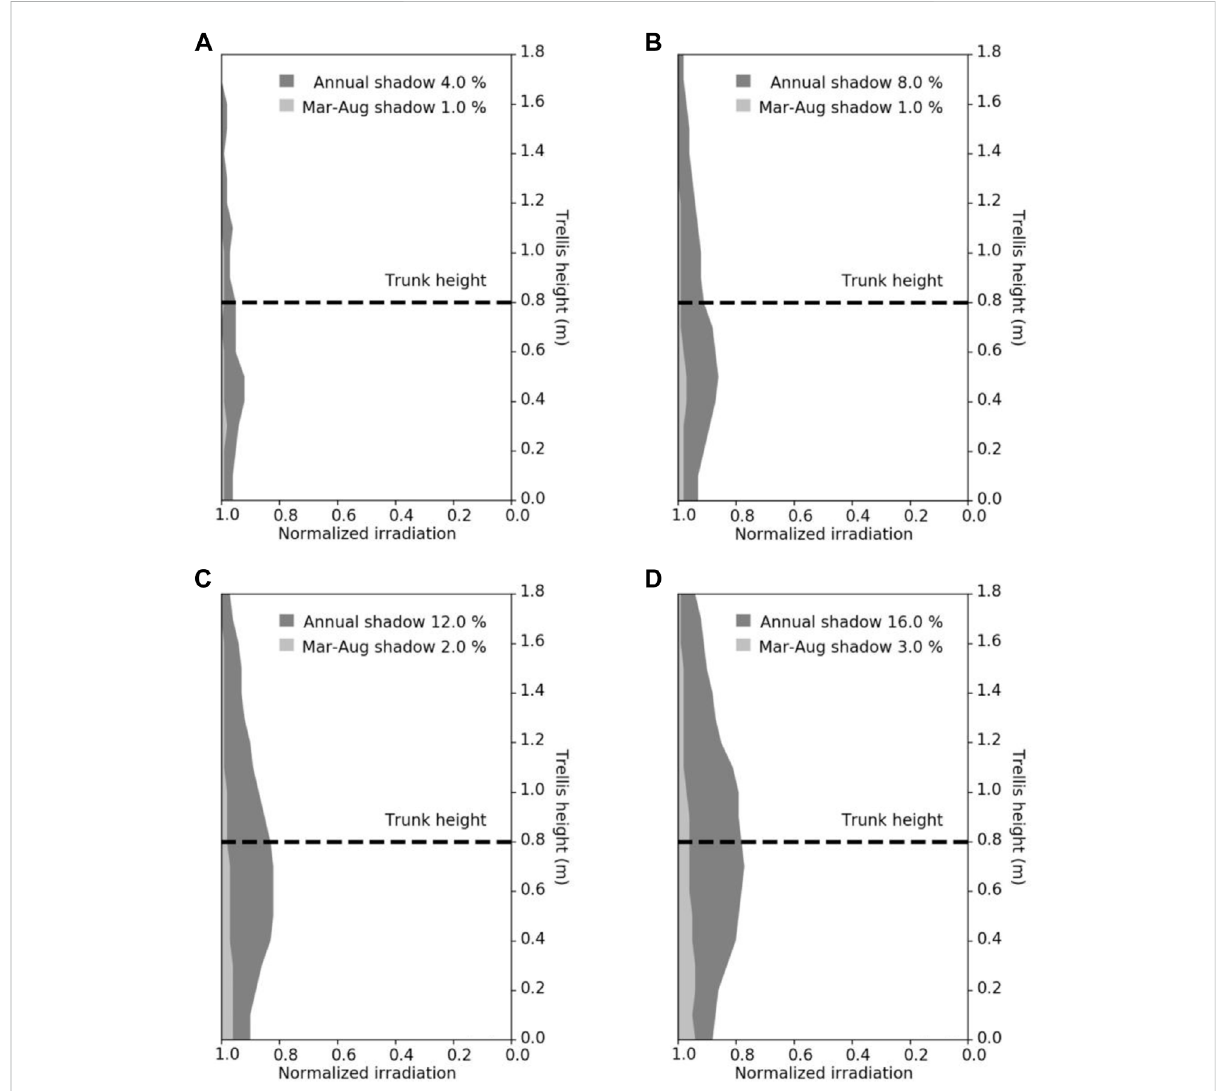
FIGURE 3 Normalized irradiation at different heights of the trellis (L) considering different PV area above the vineyard trellis (A) 0.2 m, (B) 0.4 m, (C) 0.6 m and (D) 0.8